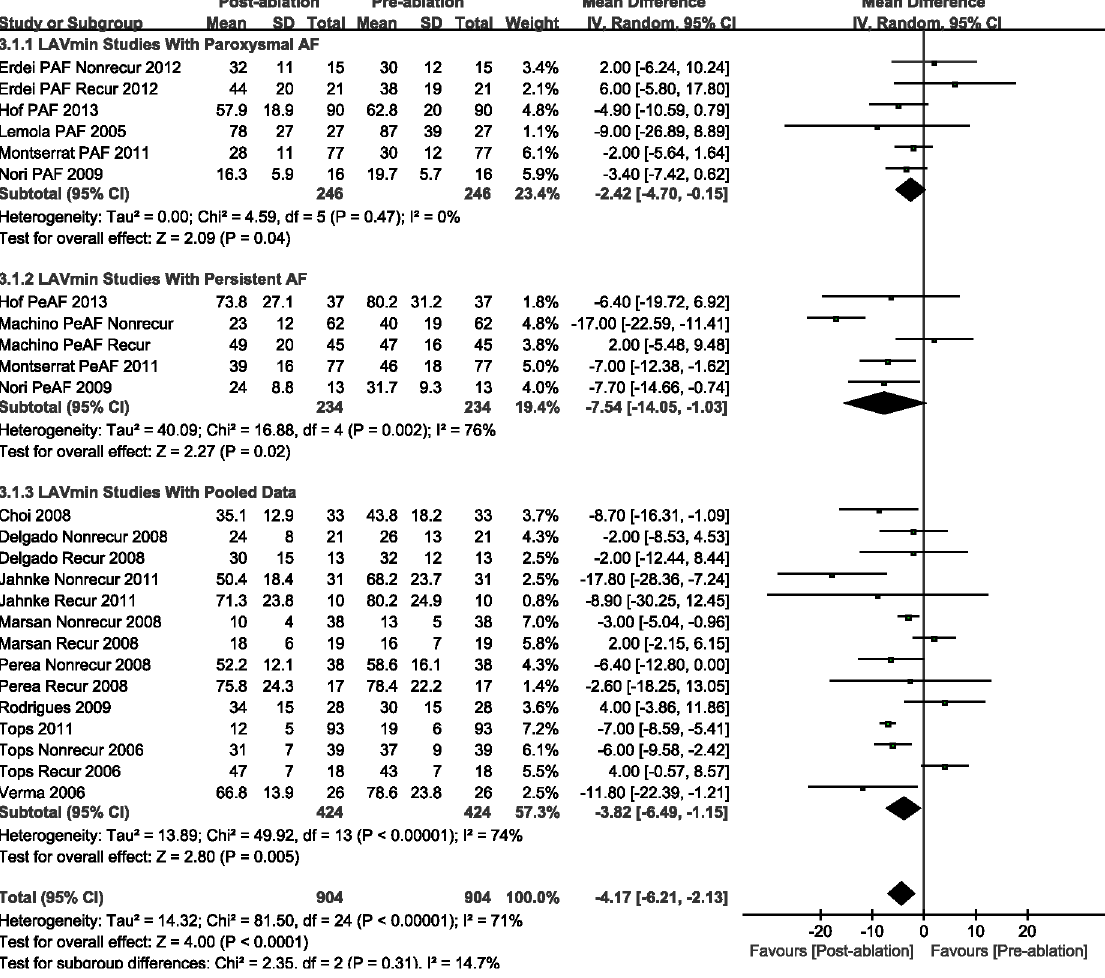
Fig 4. A forest plot of comparison: changes in minimum left atrial volume (LAVmin) pre-ablation and